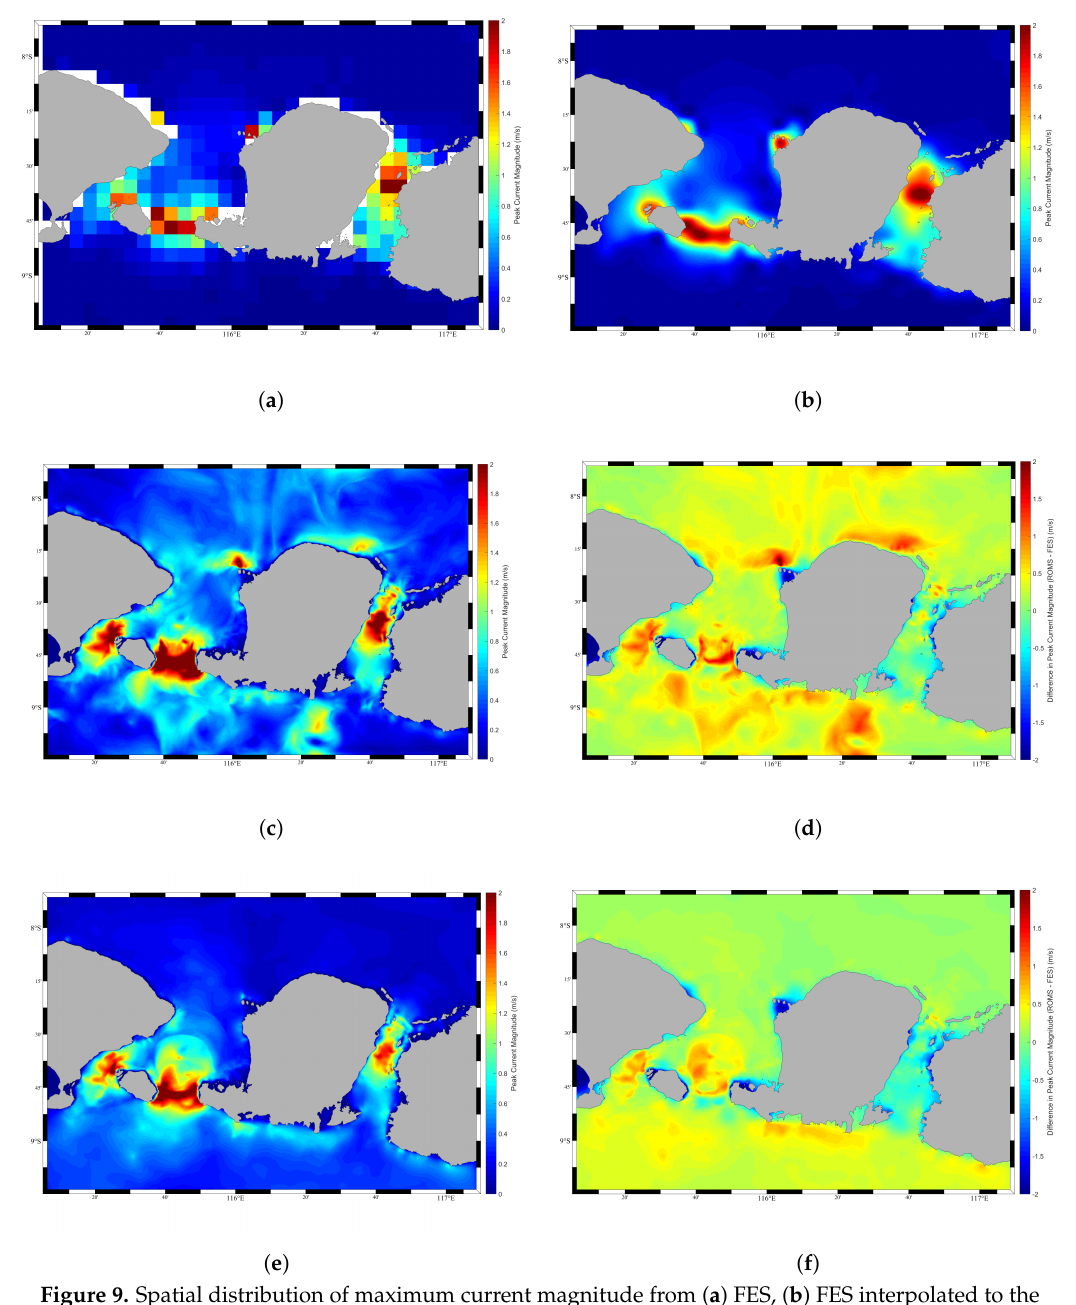
Figure 9. Spatial distribution of maximum current magnitude from ( a ) FES, ( b ) FES interpolated to the ROMS grid, ( c ) ROMS TO, ( e ) ROMS ITF. Figures ( d , f ) show the difference between interpolated FES data and the ROMS TO simulation ( d ) and the ROMS ITF simulation ( f